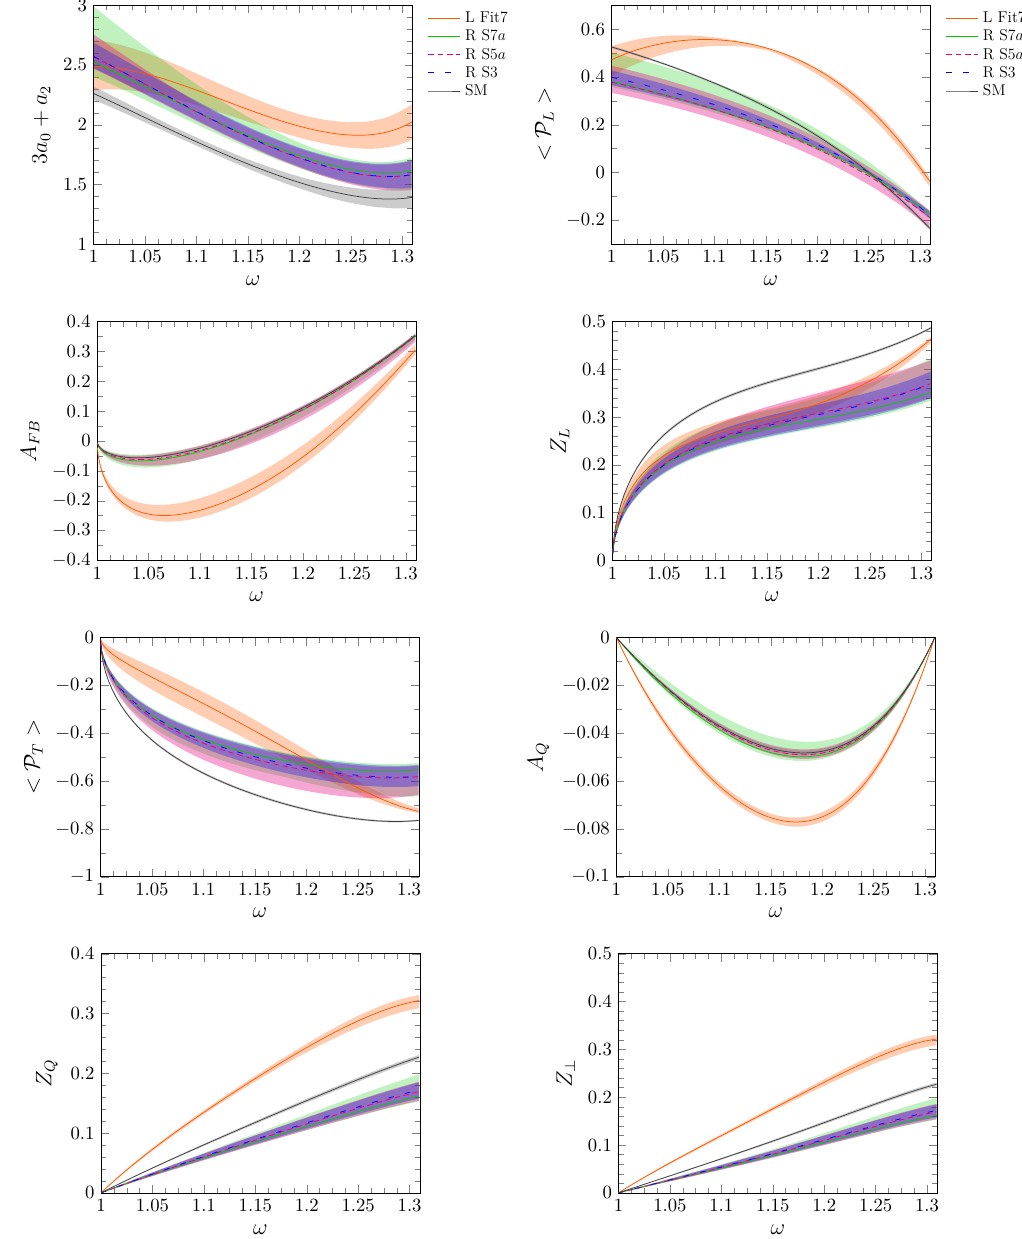
Figure 2 . Predictions for the semileptonic observables p 3 a 0 (cid:0) a 2 q , x P CM and Z introduced in eq. (3.46), as a function of ω , for the Λ K show results obtained within the SM, the NP model Fit 7 of ref. [33], which involves only left- handed neutrinos, and other three ones taken from ref. [61], where all included NP operators use right-handed neutrino fields. Error bands account for uncertainties induced by both form-factors and fitted Wilson coefficients (added in quadrature). The right-handed neutrino scenario 3 and the SM lead to the same results for the A